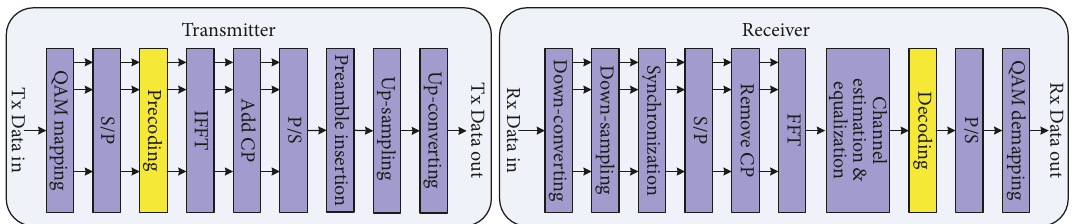
Figure 1: Block diagram of OFDM VLC system with ZCM precoding.